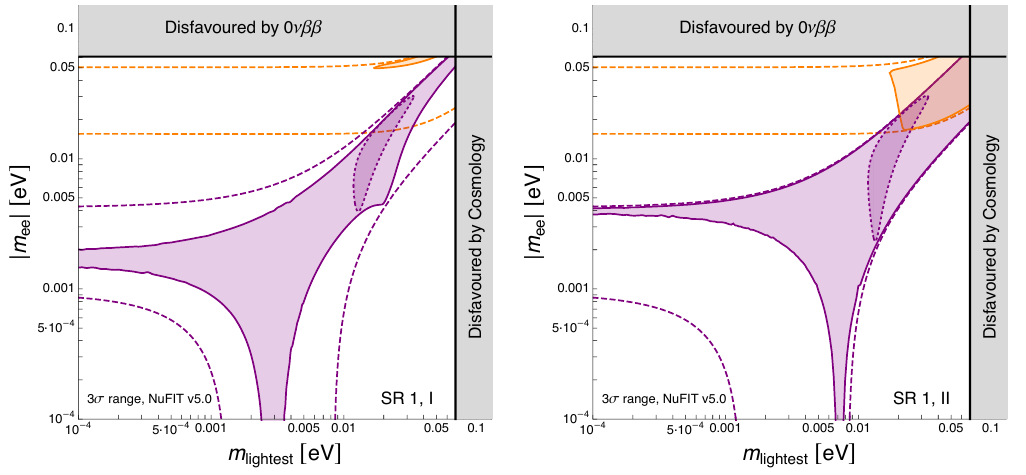
Figure 2 . Allowed ranges for | m ee | for SR 1 in case I and case II. The purple/orange dashed region is the 3 σ allowed region without sum rules for NO/IO. The lightly (dark) shaded purple/orange regions is the 3 σ (best fit) allowed region for NO/IO. For more details, see main